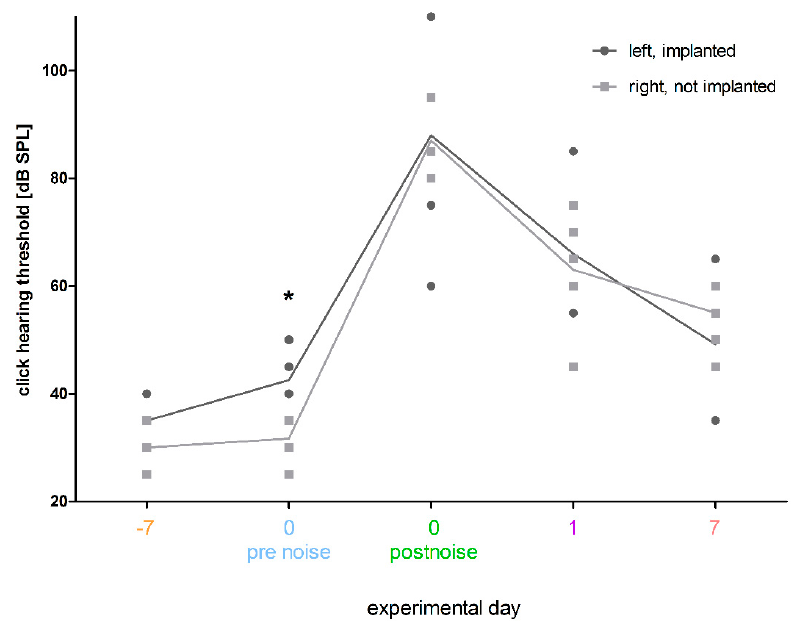
Figure 7. Effect of implantation and noise on ABR click thresholds over time. The mean (line) and individual (points) click hearing thresholds of left (implanted) (dark grey) and right (not implanted) (light grey) ears are illustrated over time. Since overlaps occur, the number of points does not correspond to the number of animals. There is a significant difference between the two groups on day 0 before noise trauma, i.e., 7 days after HDD implantation with left (implanted) ears showing a higher threshold. All other time points show no significant difference in the click hearing thresholds between groups. * p ≤ 0.05.